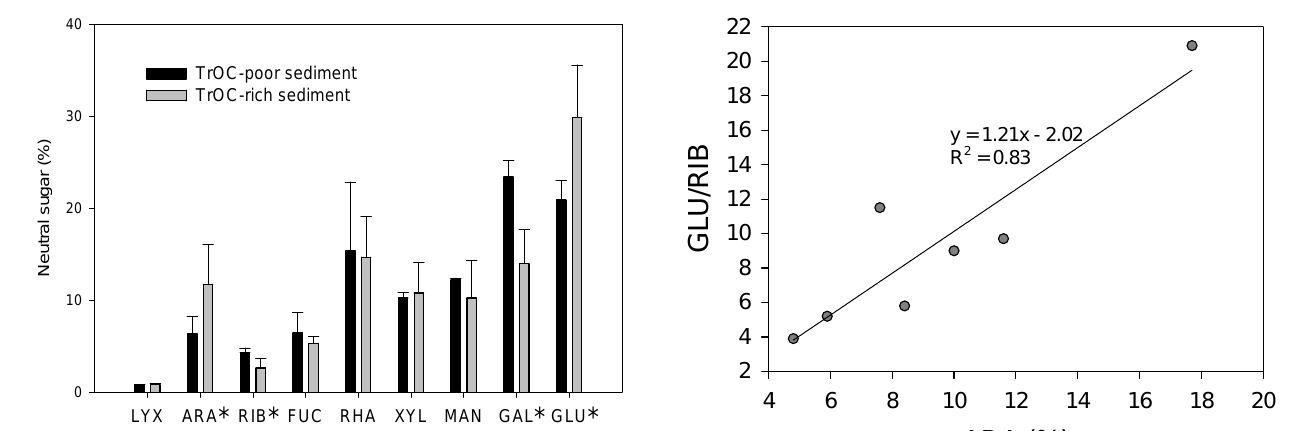
Fig. 7. Average neutral sugar composition (wt %) of surface sed- iments showing that sediments from Lingdingyang Bay were en- riched in terrestrial organic carbon ( > 70%) and sediments collected from the shelf of the South China Sea had lower terrestrial organic carbon contents ( < 40%). The distinction between TrOC-rich and TrOC-poor is explained in the text. Error bars represent the stan- dard deviation. Sugars marked with “*” signify that statistically significant difference occurred between TrOC-rich and TrOC-poor (see text for details).